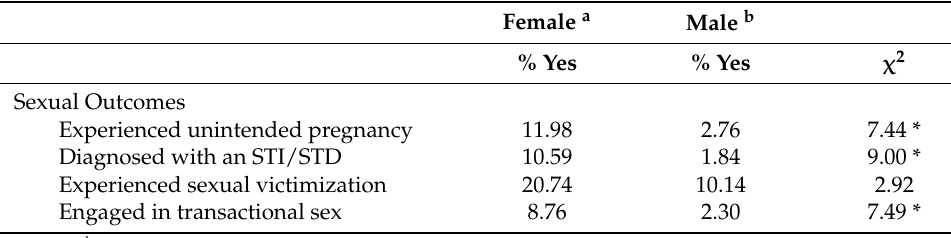
Table 3. Chi-square Comparisons Between Female and Male